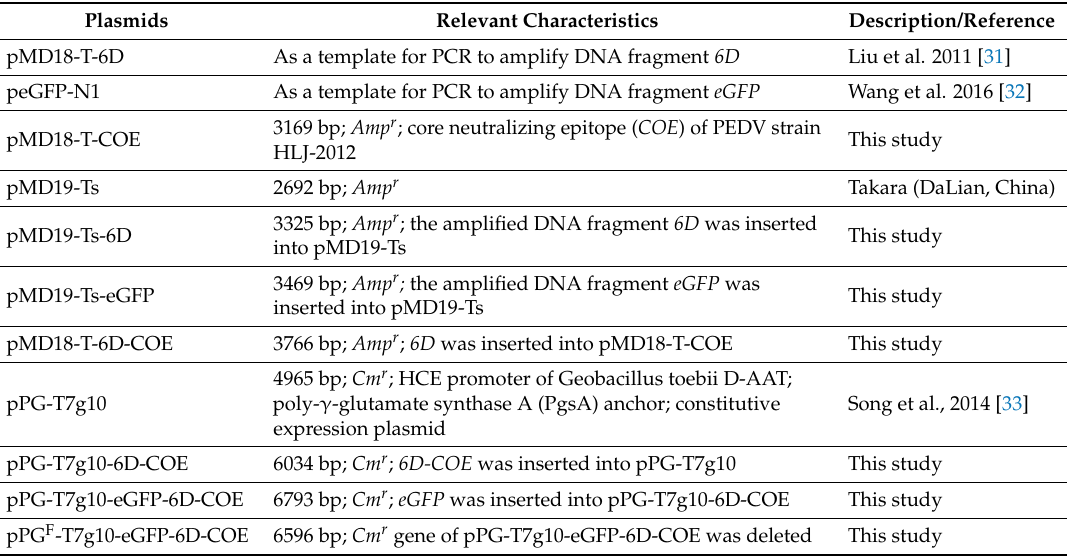
Table 1. Details of plasmids used in this